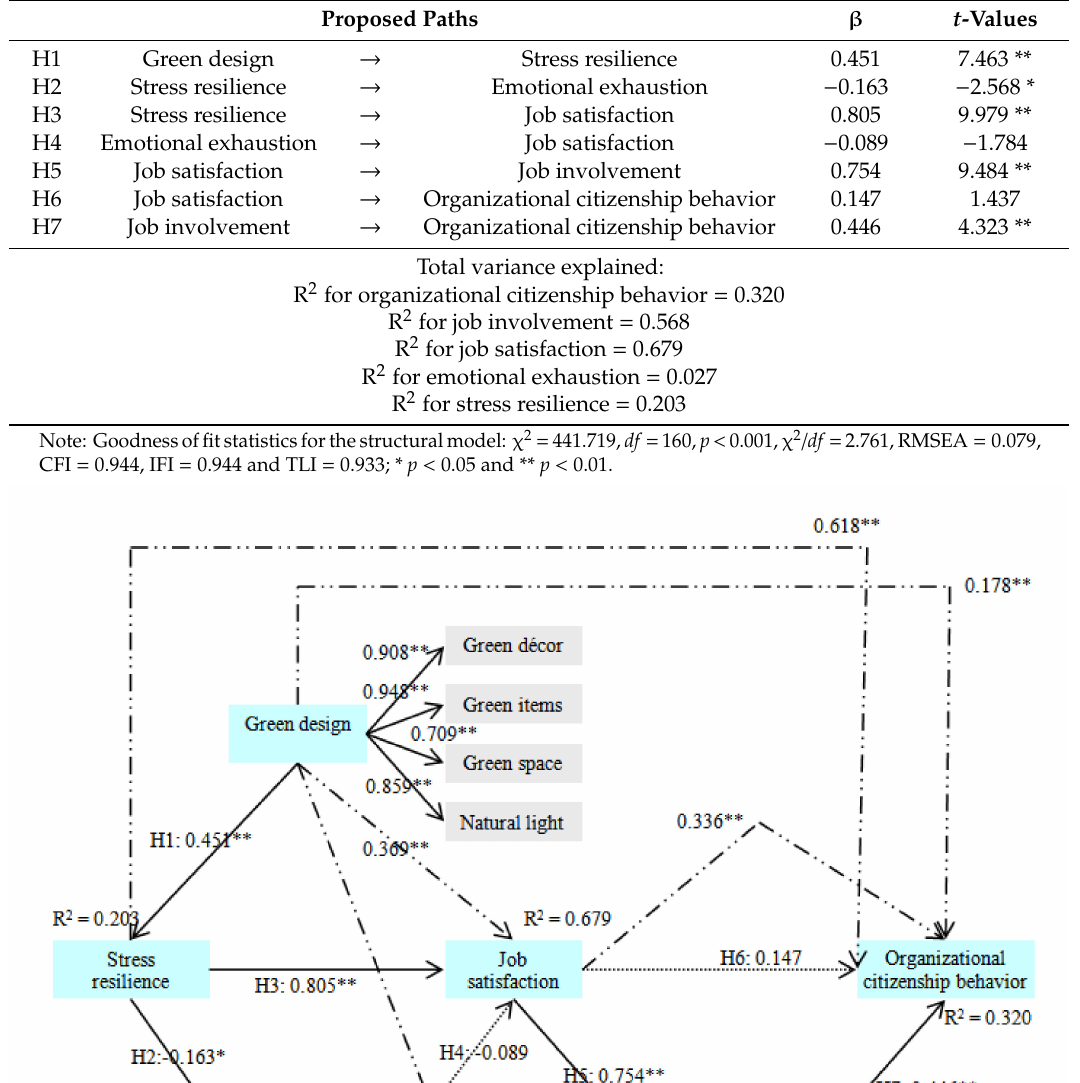
Table 2. Structural model estimation results ( n = 280).